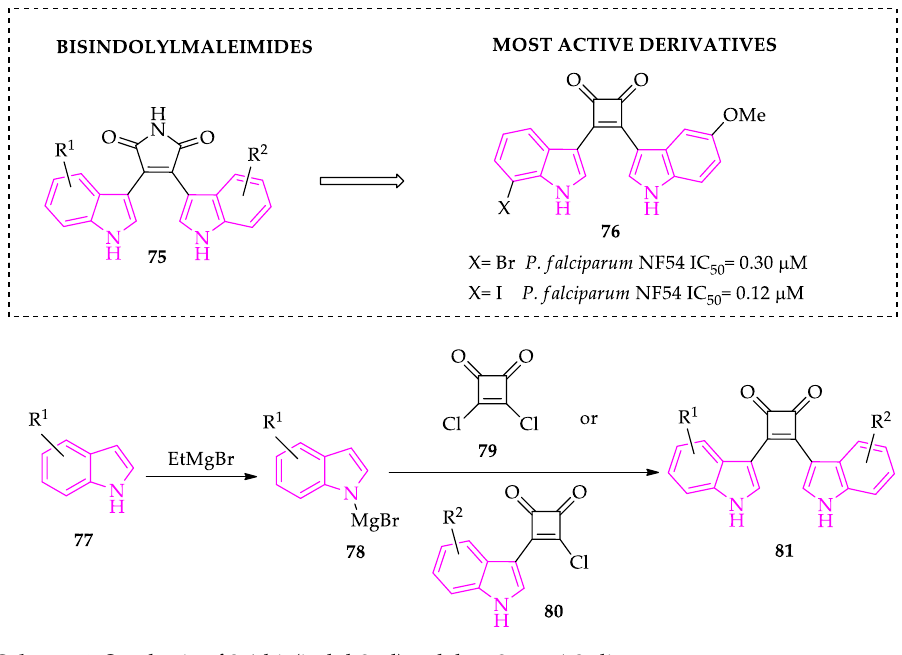
Figure 9. Activities of racemic spiroazepineindole 82 and individual